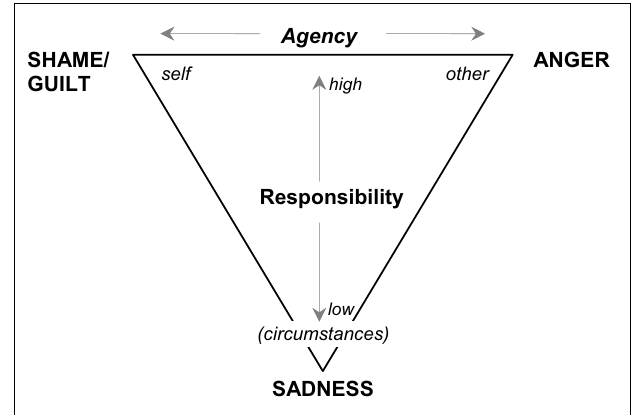
FIGURE 1 | Emotional responses to negative events varying in the source of agency and responsibility.